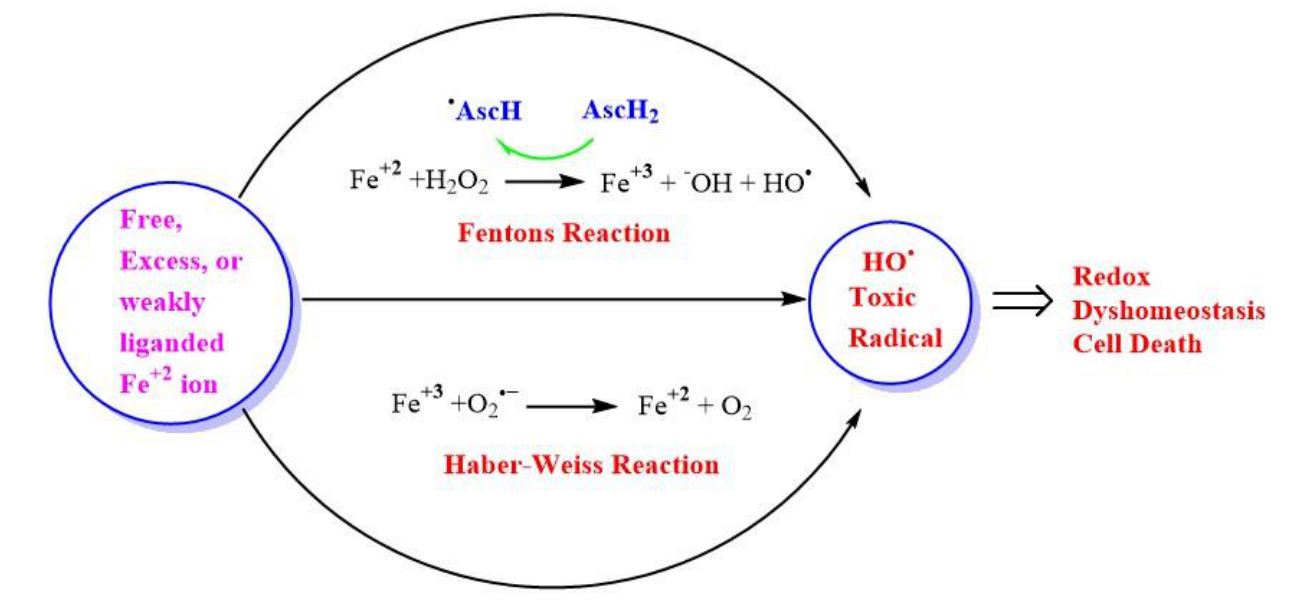
Figure 4. Generation of highly reactive oxidant hydroxyl radicals (HO • ). Free ferrous ion (Fe +2 ) initiates Fenton reaction with hydrogen peroxide (H 2 O 2 ), leading to the generation of a highly reactive hydroxyl free radical (HO • ). Ascorbic acid (AscH) also, take part in recycling the ferric ion (Fe +3 ), through the generation of (Fe +2 ) and ascorbyl radical (AscH • ). Su- peroxide radical anion (O 2 • − ) can also react with (Fe +3 ) in the Haber-Weiss reaction leading to the production of (Fe +2 ) , which then again starts redox cycling to generate HO • . The HO • leads to oxidative stress-induced lipid peroxidation, mi- tochondrial dysfunction, and an increase in intracellular free-calcium concentration, and finally causing redox imbalance within the cell and ultimately leading to cell